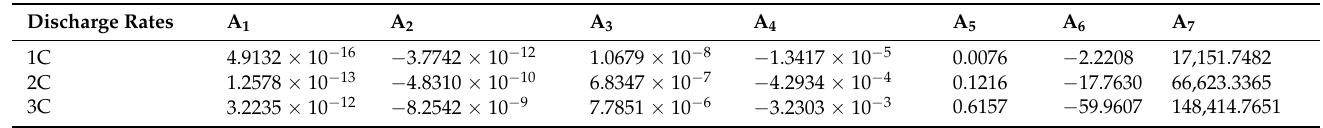
Table 2. The empirical coefficients used to model the heat generation rate of the battery during the discharging cycle